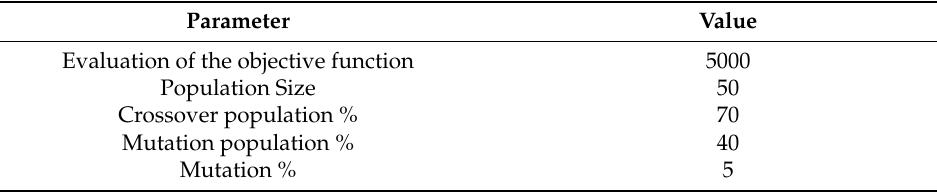
Table 3. T-NSGA-II-SSD parameters.